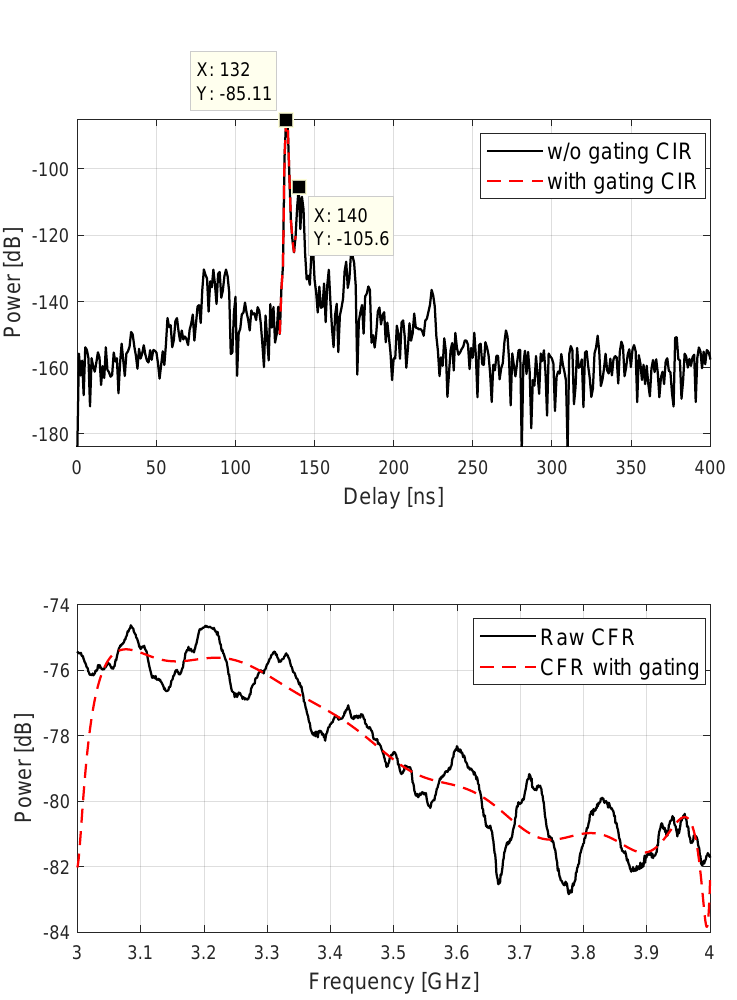
Figure 6. The CIRs from one Tx antenna to Rx antenna with and without gating ( top ) and their associated CFRs ( below